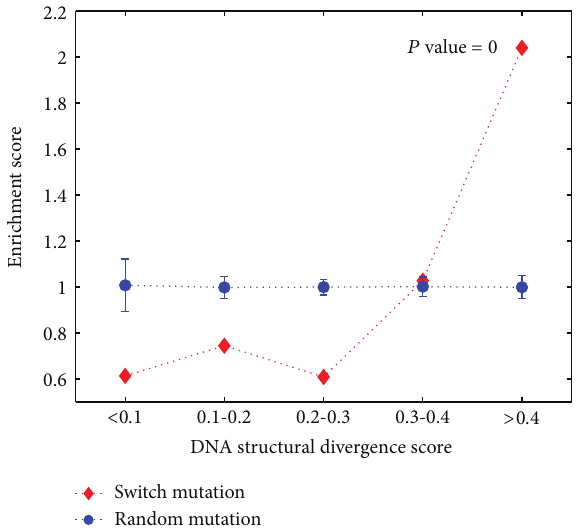
Figure 5: Switch mutations show extremely large DNA structural